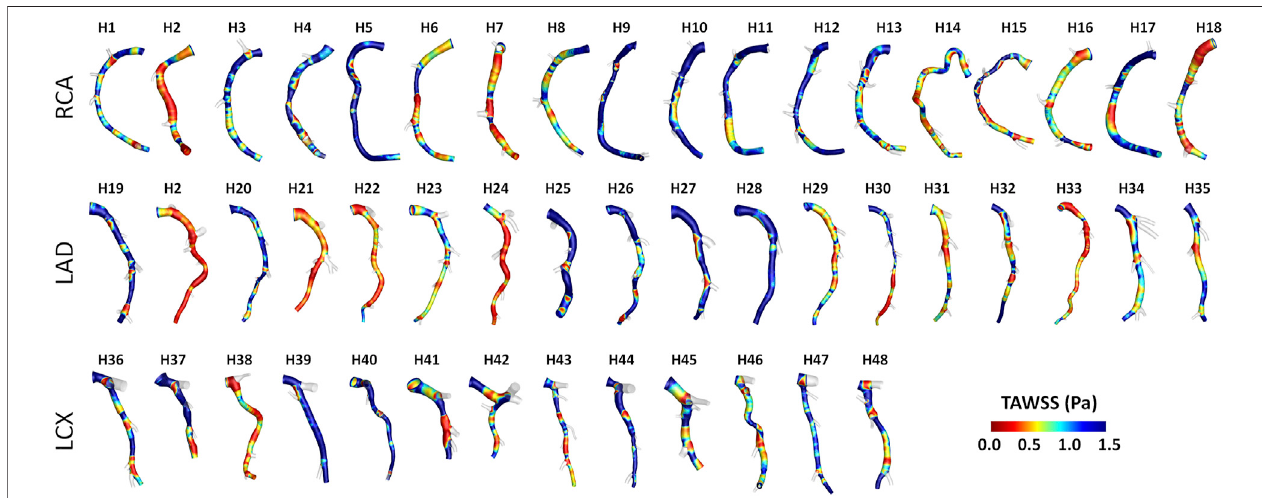
FIGURE 7 | TAWSS distribution at the luminal surface of the 49 human coronary arteries. Red color highlights luminal regions exposed to low TAWSS values. Labels from H1 to H48 identify the single patient. Right (RCA), left anterior descending (LAD), and left circum fl ex (LCX) coronary artery geometries are grouped.